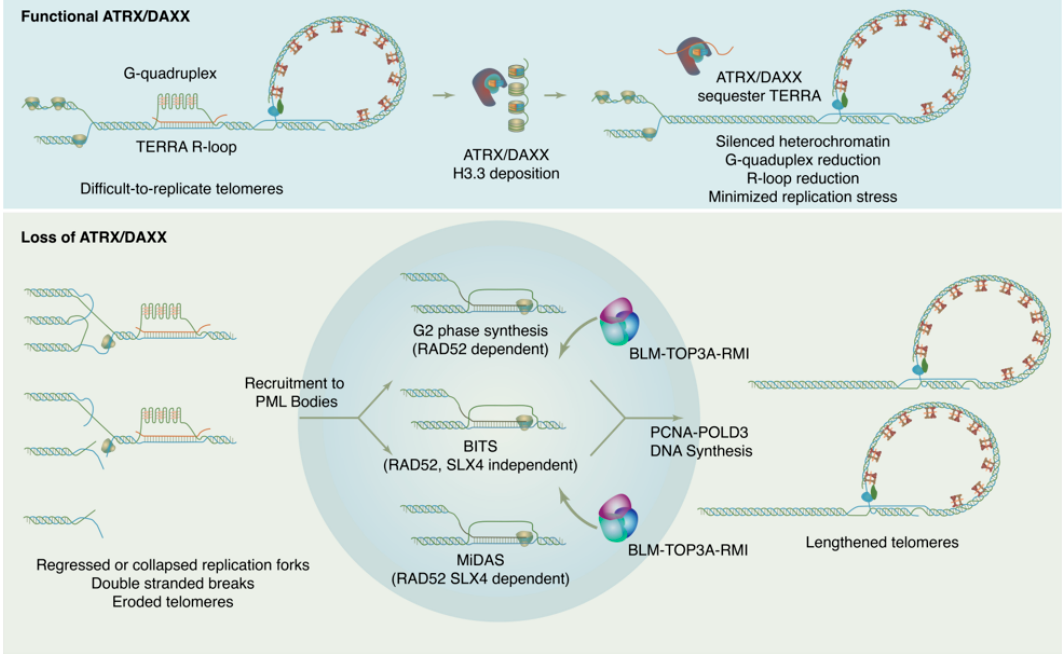
Figure 2. ATRX/DAXX suppresses ALT by maintaining chromatin states and reducing replication stress at telomeres. In absence of ATRX/DAXX, chromatin loses silencing, TERRA transcription increases, G4s and R-loops increase, and replication stress results. This replication ultimately feeds forward into self ‐ perpetuating ALT.